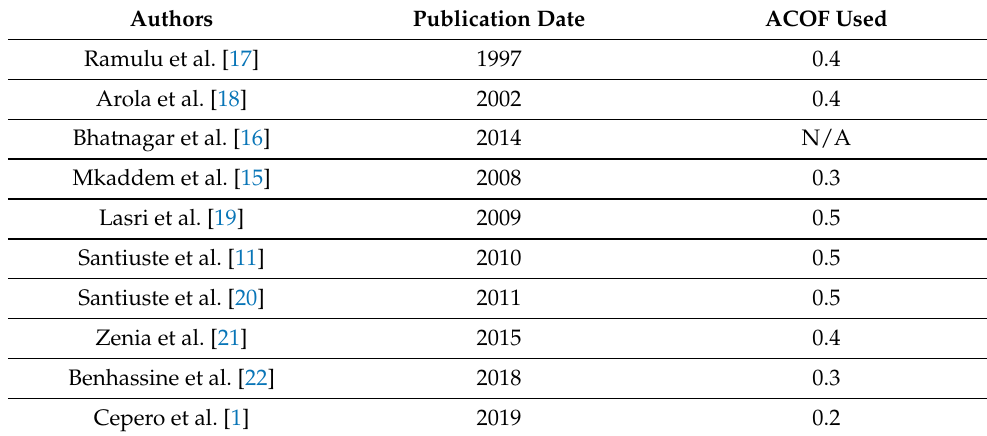
Table 1. Orthogonal cutting COF comparison table for previous